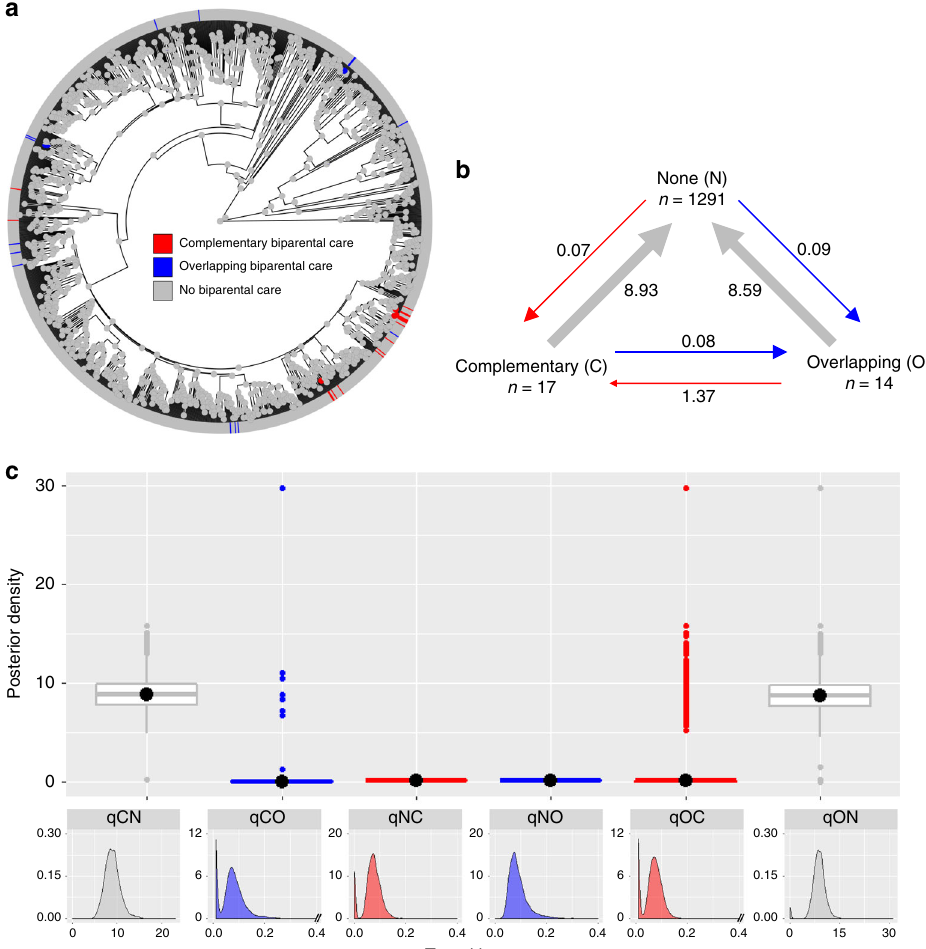
Fig. 5 The evolution of biparental care forms. a Overlapping and complementary care plotted on the phylogeny using stochastic character mapping with the R package phytools 73 . b Summary diagram of the transition rates across the three possible character states of biparental care from the RJ Multistate model of evolution. The sample sizes for each character state are reported; the arrows are scaled to re fl ect the magnitude of mean transition rates with the mean value also indicated. c Posterior distributions of the transition rates from the RJ Multistate model of evolution are shown as box plots for comparison and as posterior density plots for each transition rate alone. The central black dot in the box plots indicates the median, the box the upper and lower quartiles, the vertical lines the 95% credible intervals of the posterior distributions, and the fi lled dots beyond the lines indicate outlier estimates. Transition rates among character states in b and c are indicated as follows: complementary to no biparental care (qCN, grey), complementary to overlapping biparental care (qCO, blue), no biparental care to complementary care (qNC, red), no biparental care to overlapping care (qNO, blue), overlapping to complementary biparental care (qOC, red) and overlapping to no biparental care (qON,